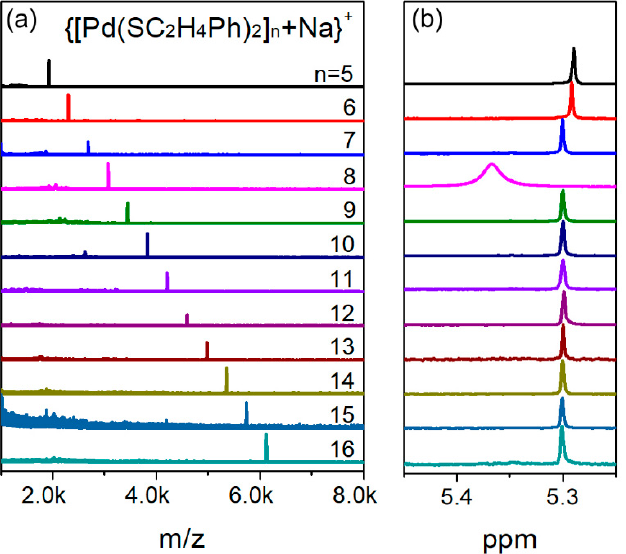
Figure 4. MALDI-TOF-MS of each Pd n (PET) 2n (5 ≤ n ≤ 16) ( a ) and 1 H NMR spectra in the region from 5.25 to 5.45 ppm of the mixture of CH 2 Cl 2 and each Pd n (PET) 2n (5 ≤ n ≤ 16) ( b ).